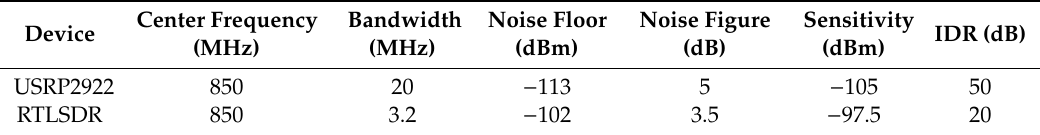
Table 1. Device Parameters.